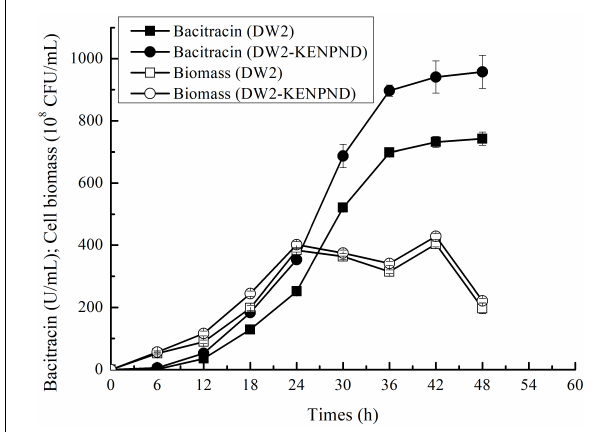
FIGURE 7 | The fermentation process curves of B. licheniformis DW2 and DW2-KENPND.